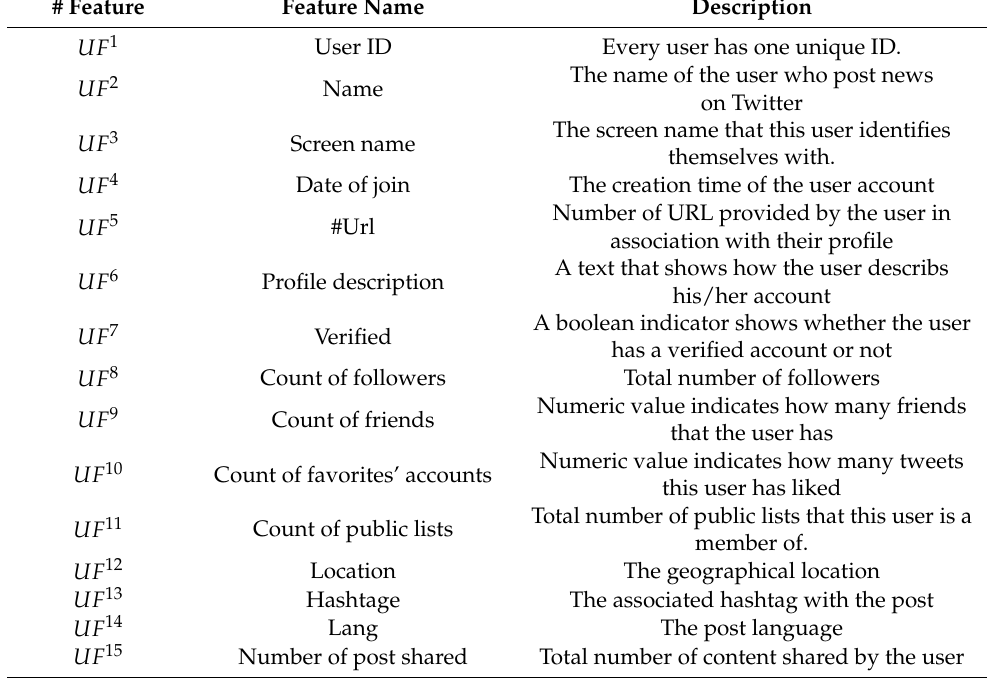
Table 2. User-based features.